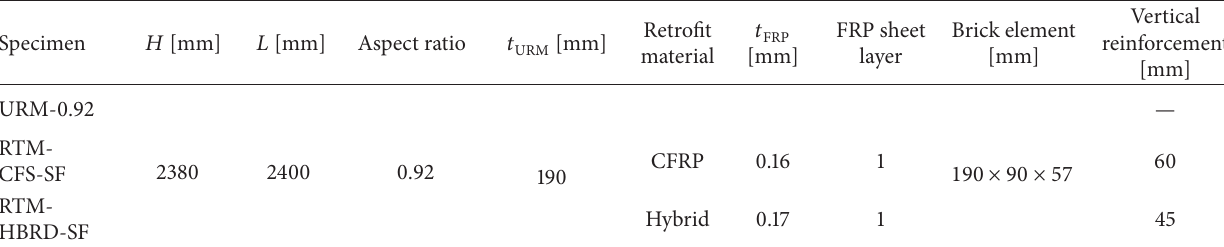
Table 4: List of specimens.